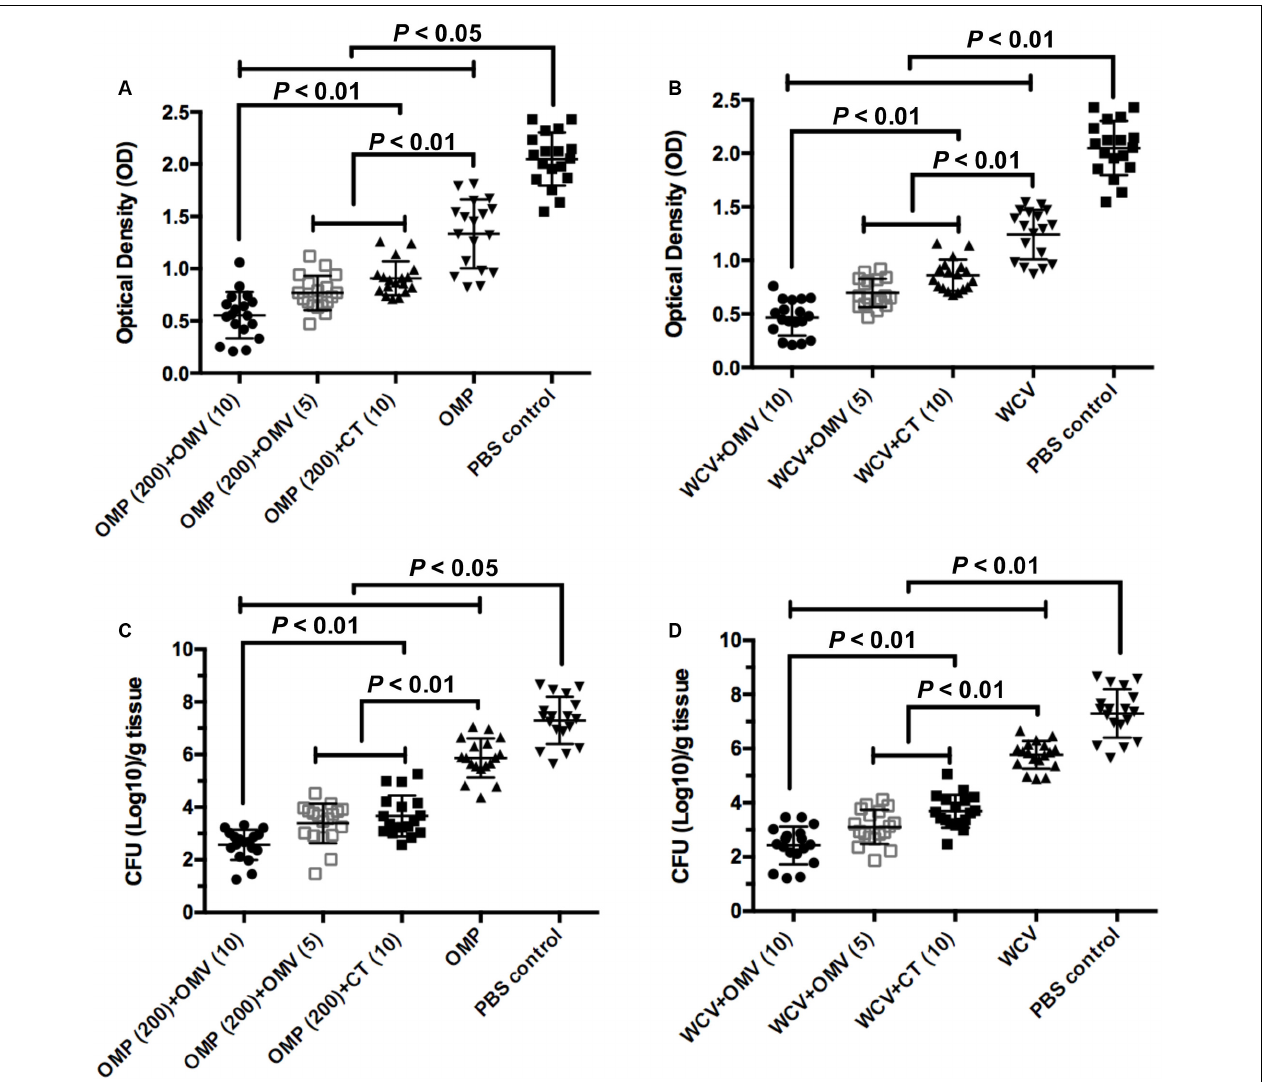
FIGURE 7 | OMVs as adjuvant elicit protection against H. pylori SS1 infection. Stomach tissue were collected from immunized mice and washed by PBS buffer to determine the urease activity and bacterial load quantitation. (A,B) Urease activity in stomach homogenates from mice immunized OMPs or WCV with OMVs or CT as adjuvant was assessed two weeks after the challenge infection. (C,D) H. pylori colony counts in stomach homogenates were quantified. The means were compared using the least significant difference test. P < 0.05 and P < 0.01 reflect statistical significance between the related